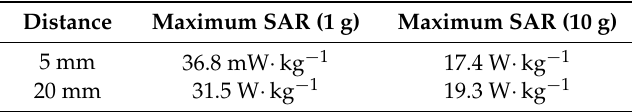
Table 2. Typical Locations and Values of 1 g and 10 g SAR for I2O Body Model.